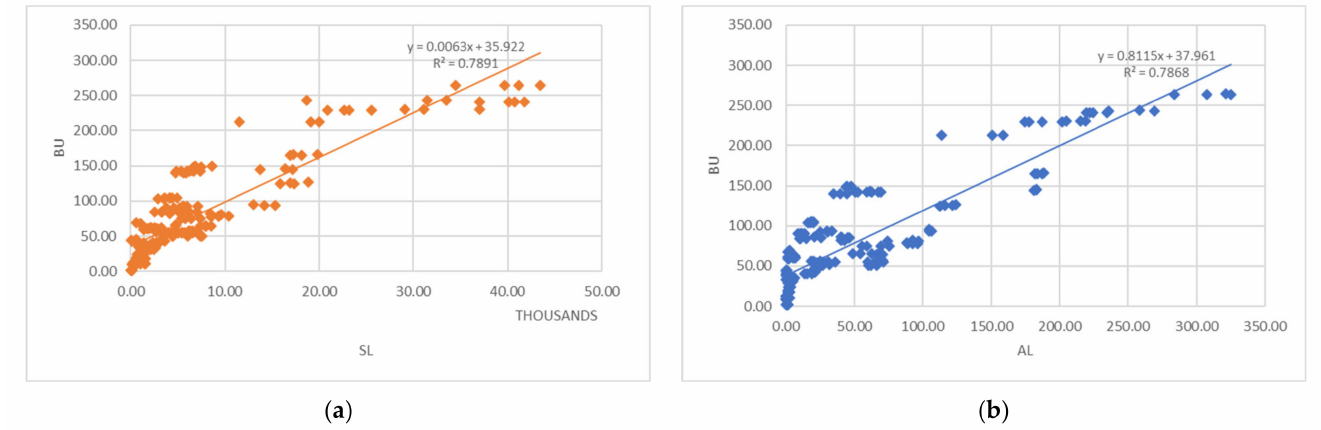
Figure 6. The correlation between geographical variables (remotely sensed data extraction); ( a ) BU and SL; ( b ) BU and AL.